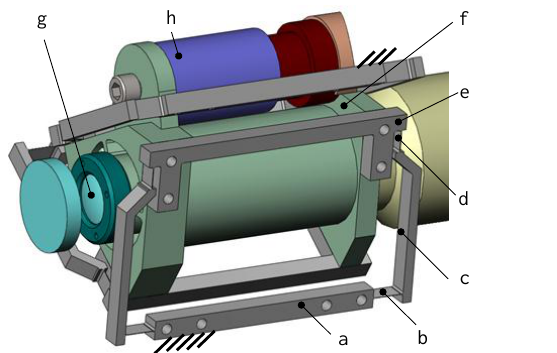
Figure 3. Working principle (using an offset shim) and photo of a monolithic Nanoconverter.